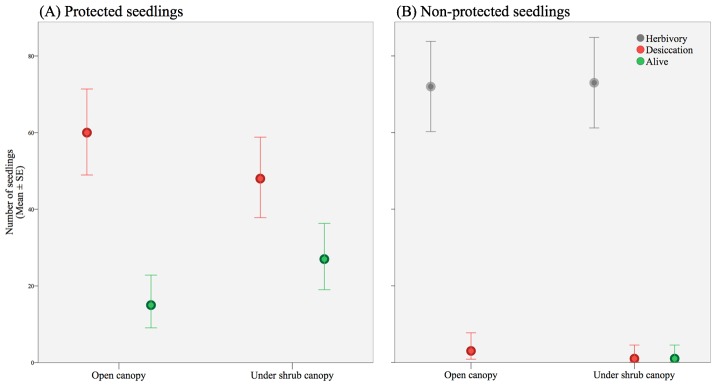
Average wine palm seedling mortality caused by ‘desiccation’ (when it was dried) or ‘herbivory’ (when damaged, broken, or chewed stems or leaves).Death and survival (‘alive’) rates were scored after 18-month study period to (A) protected and (B) non-protected seedlings to browsers. Error bars indicate the standard error (SE) of the mean.